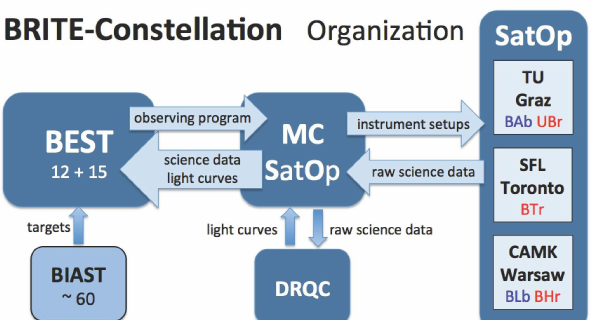
Figure 8. Organisation structure of BRITE-Constellation. BEST: BRITE Executive Science Team, MC: Mission Control, SatOp: Satellite Operation, DRQC: Data Reduction & Quality Control, BIAST: BRITE International Advisory Science